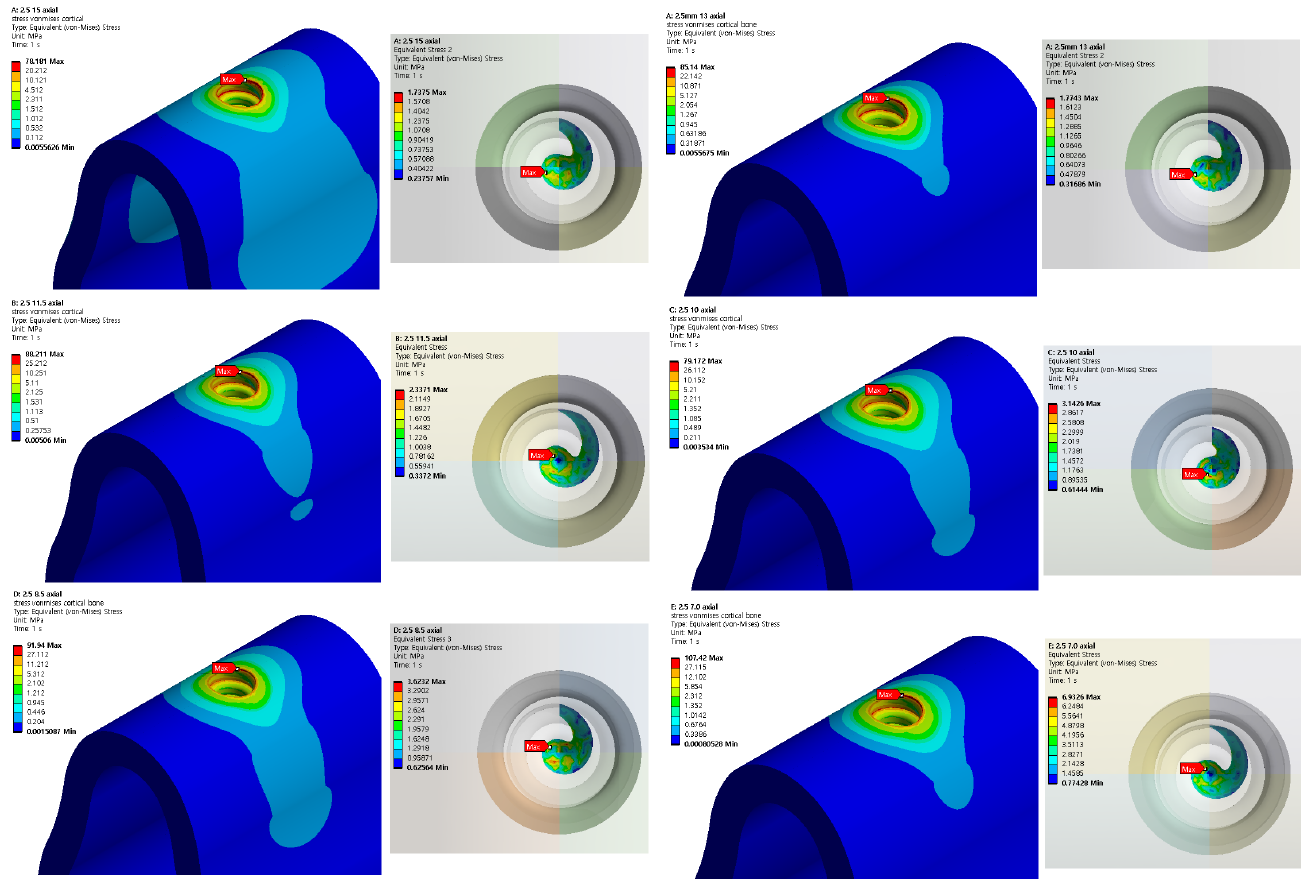
Figure 9. Von Mises stress on cortical bone, bottom of cancellous bone (2.5